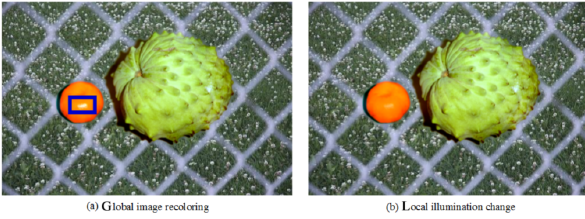
Fig. 4 Selective modification to provide global recoloring and local illumination change. Even if global or local operators are applied to the cloned composition, the resulting texture still remains